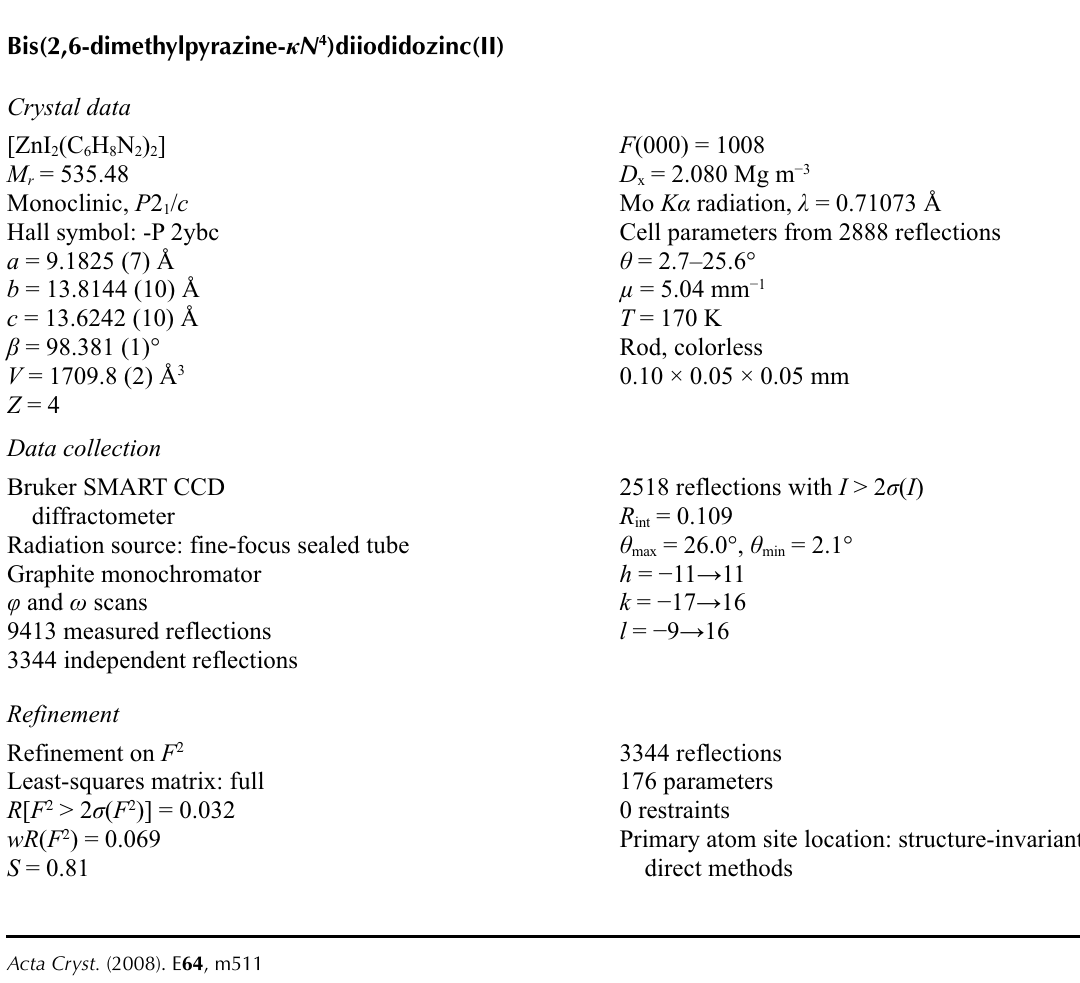
The structure of the title compound showing the atom-labeling scheme. Displacement ellipsoids are shown at the 30% probability level. H atoms are represented as small spheres of arbitrary